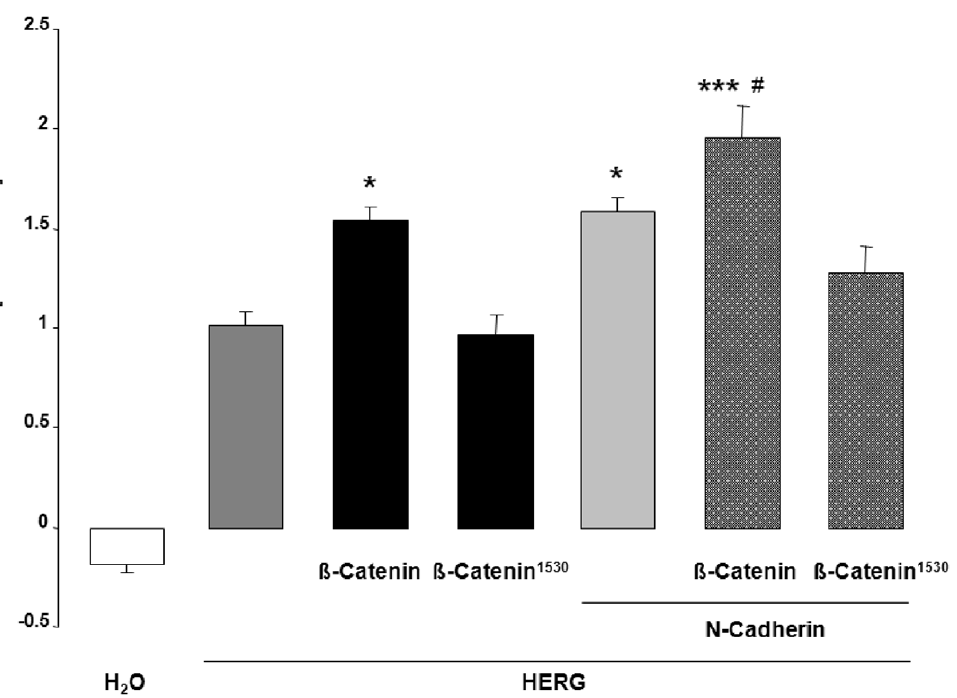
Figure 5. HERG currents are insensitive to truncated ß-catenin 1–530 and stimulated by N-cadherin. Arithmetic means 6 SEM (n=10–20) of the normalized outward tail current following depolarization to + 80 mV and recorded in oocytes injected with water (white bar), or with cRNA encoding HERG (dark grey bar) with ß-catenin (first black bar) or with the truncated mutant ß-catenin 1–530 (second black bar), without and with co- expression of N-cadherin (dotted dark grey bars). *, ***indicate statistical significance (p , 0.05, p , 0.001) from the absence of HERG cRNA, # (p , 0.05) indicates statistical significance from the absence of N-cadherin.